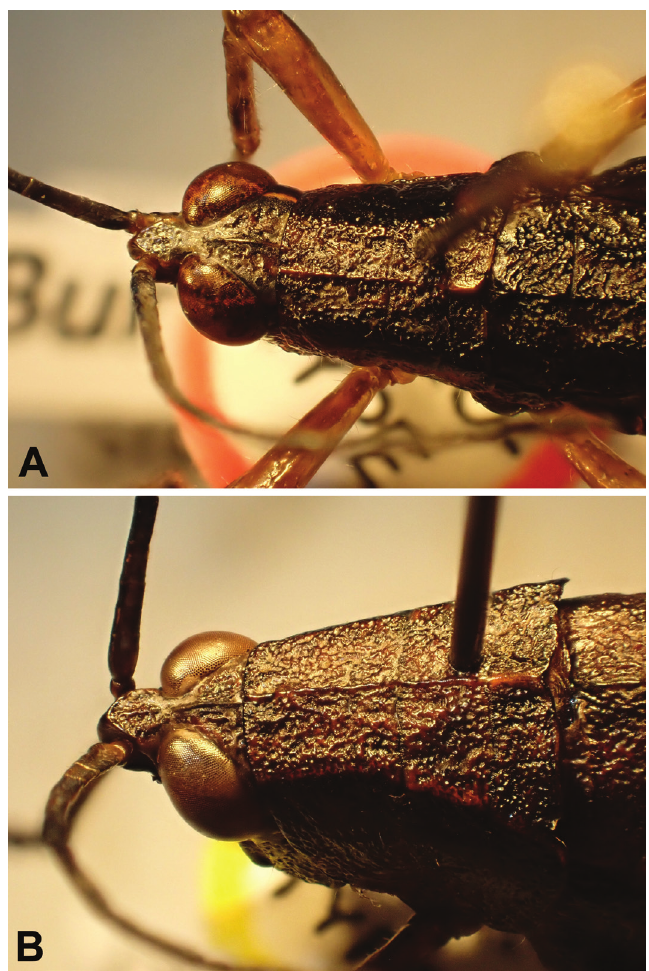
Fig. 3. Lateral view of head and pronotum of male ( A ) and female ( B ) Burttia caerulea sp.